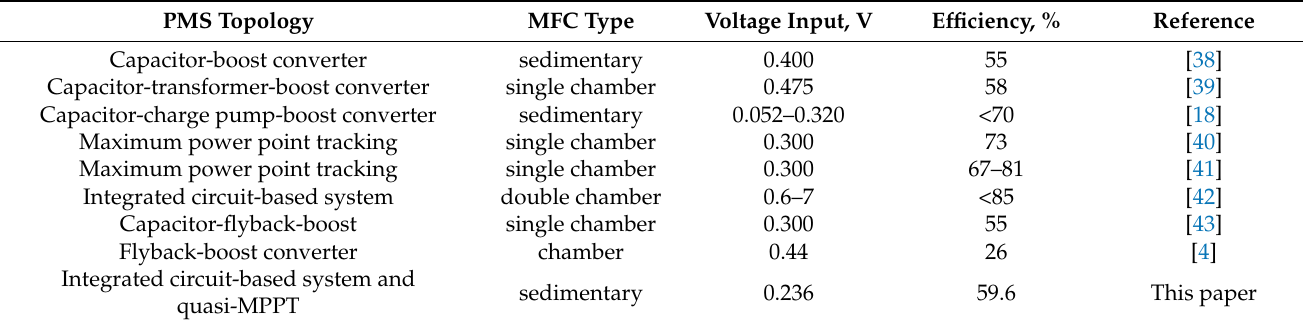
Table 6. Reported primary performance indicator of PMS powered by